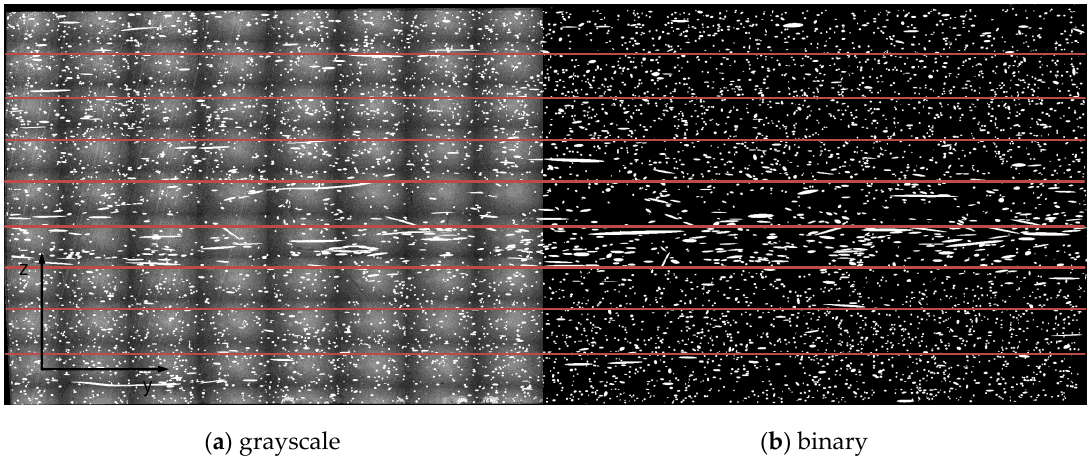
Figure 12. Different states of image processing to determine the fiber orientation. Figure 12. Di ff erent states of image processing to determine the fiber orientation.